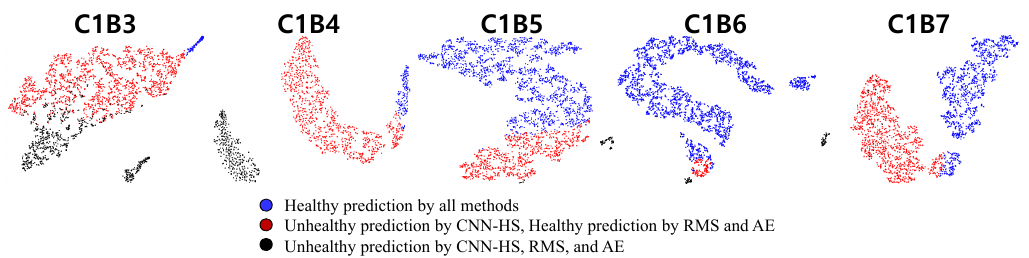
Figure 11. Feature maps of CNN-HS using t-Distributed Stochastic Neighbor Embedding (t-SNE) with principal component analysis (PCA) (condition C1).